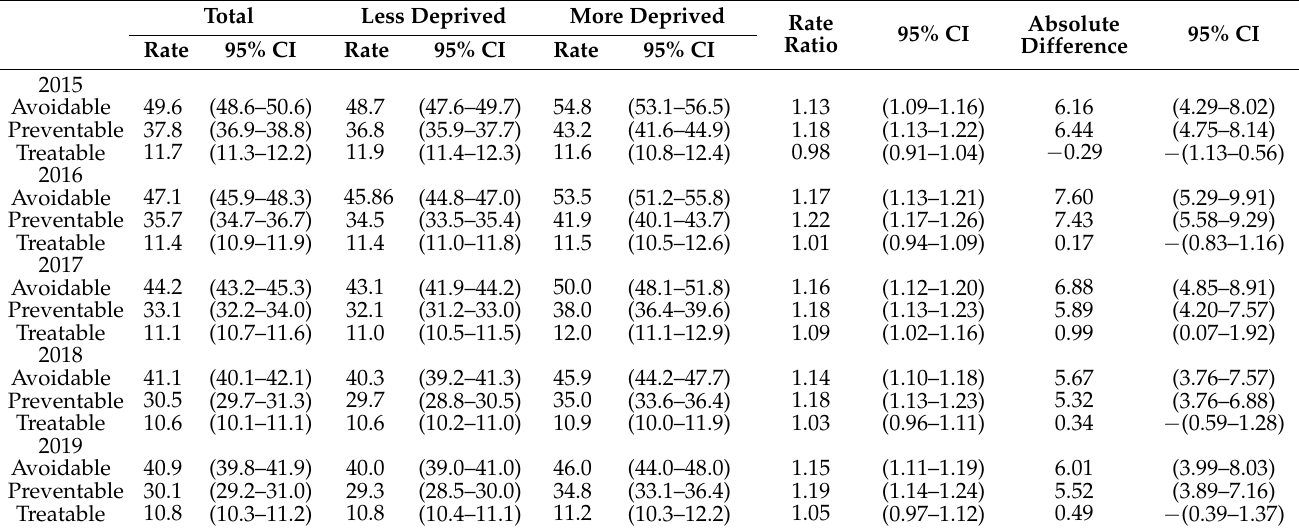
Table 2. Annual age-standardized cancer-related avoidable, preventable, and treatable mortality rates per 100,000 population by area deprivation level.